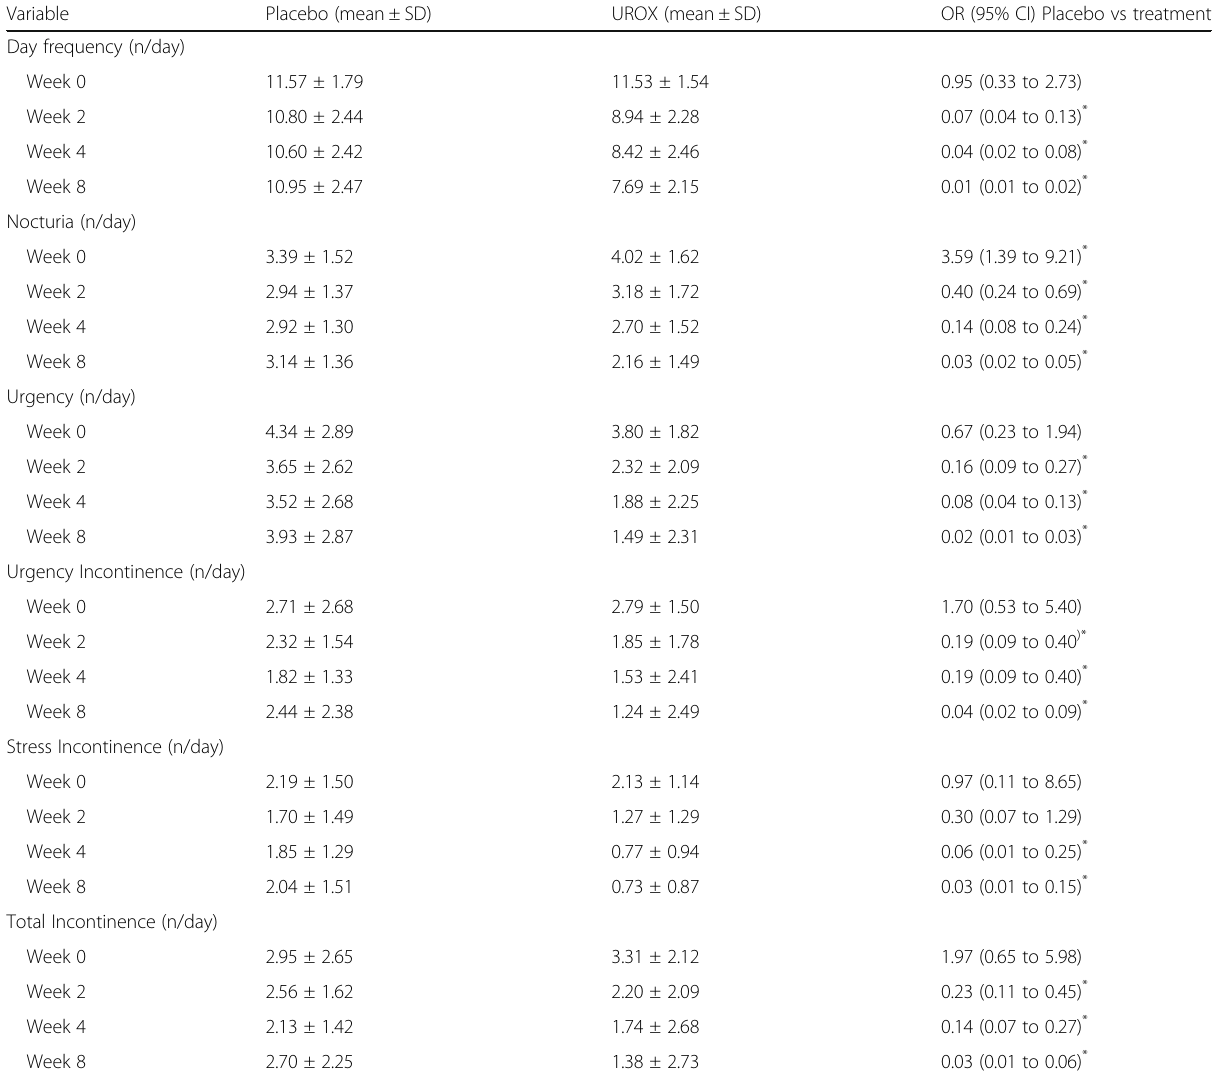
Table 2 Over active bladder and urinary incontinence symptoms frequency as recorded from micturition diaries